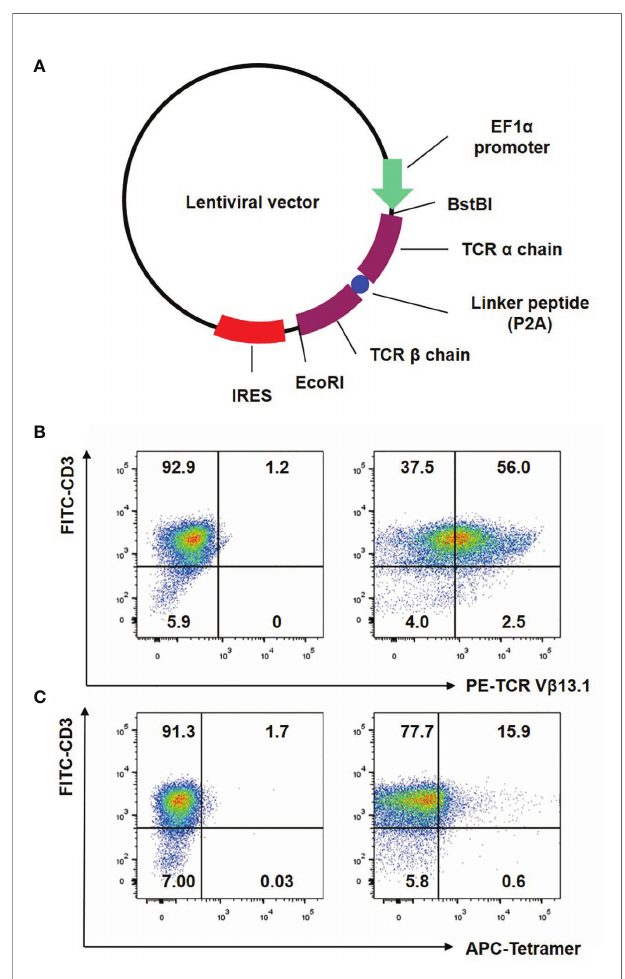
FIGURE 1 | Construction of lentiviral vector and preparation of NY-ESO-1 TCR transduced T lymphocytes. (A) The construction of lentiviral vector encoding the NY-ESO-1 TCR gene. (B) T cells were analyzed by FACS with FITC-conjugated anti-CD3 antibody and PE-conjugated anti-TCR V b 13.1 antibody that recognized the b chain of the 1G4- a 95:LY. (C) T cells were analyzed by FACS with APC- conjugated HLA-A2 tetramer containing the NY-ESO-1 157 – 165 (SLLMWITQC). The percentage of cells in each quadrant was indicated. Representative of three independent